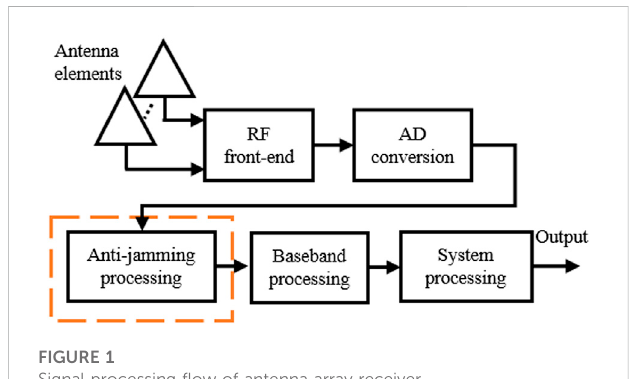
FIGURE 1 Signal processing fl ow of antenna array receiver.